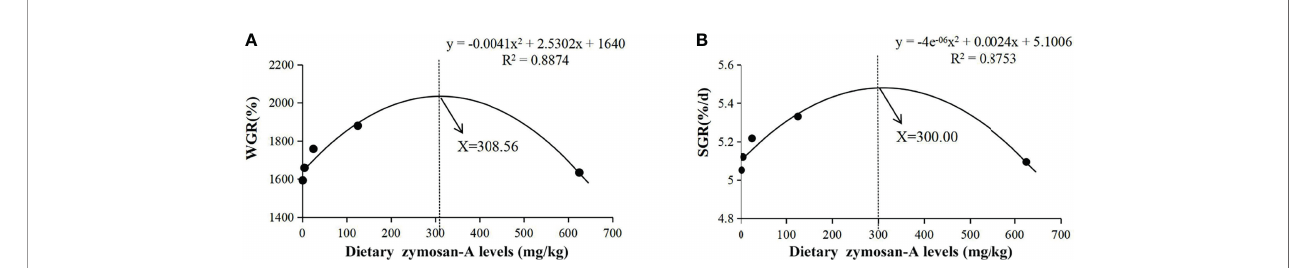
FIGURE 1 | Relationships between the level of dietary zymosan-A and weight gain rate (WGR) (A) and speci fi c growth rate (SGR) (B) in Litopenaeus vannamei fed experimental diets for 8 weeks (with fi tted second-order polynomial models).